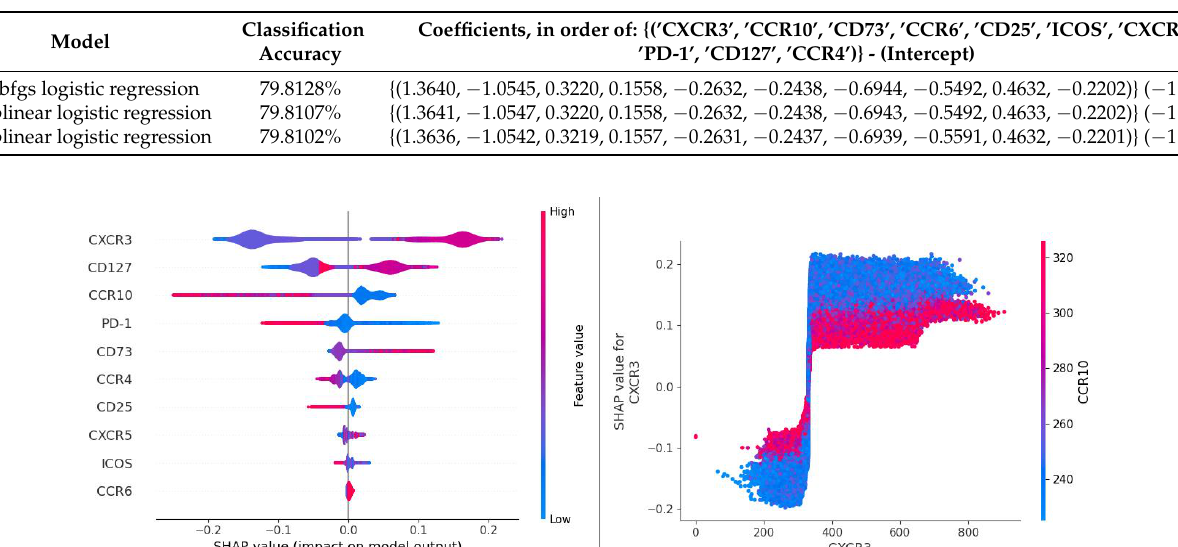
Figure 11. SHAP (Shapley Additive exPlanations) output of the RF model (Adaptive panel, Naïve CD4 cells, responders vs. nonresponders at day 1). The left panel shows a set of “beeswarm” plots reflecting individual variable importance (variables are ranked in descending order) and the impact on the model output (probability of response) depending on the value of the feature (marker). For instance, high values of CXCR3 (red color) act as a positive predictor (right side of the central axis) of response. The right panel shows an example of the interplay between two features, here CXCR3 and CCR10 (low values of CCR10 increase the predictive power of CXCR3). CCR10 was found to be the strongest modulator of CXCR3.